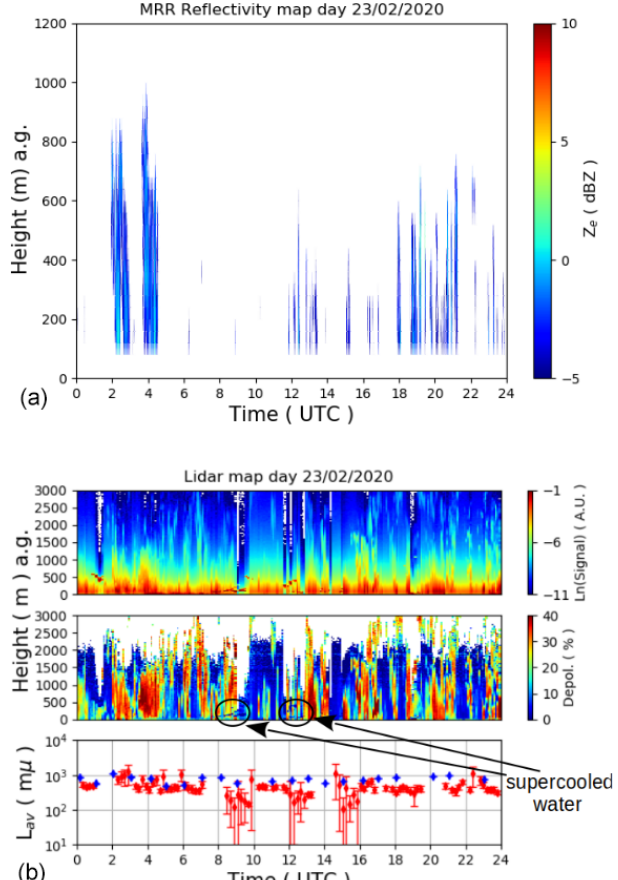
Figure 17. (a) Vertical profiles of reflectivity Z e in dBZ obtained by the MRR as a function of the UTC time in hours of the day of 23 Fe- bruary 2020. (b) In the upper and middle panels is the backscatter- ing and depolarization signals detected by the tropospheric lidar and in the lower panel the comparison of the average crystals length of the ice crystals ( L av ) retrieved from REFIR-PAD spectra (red dia- monds) with those estimated from the ICE-CAMERA (blue